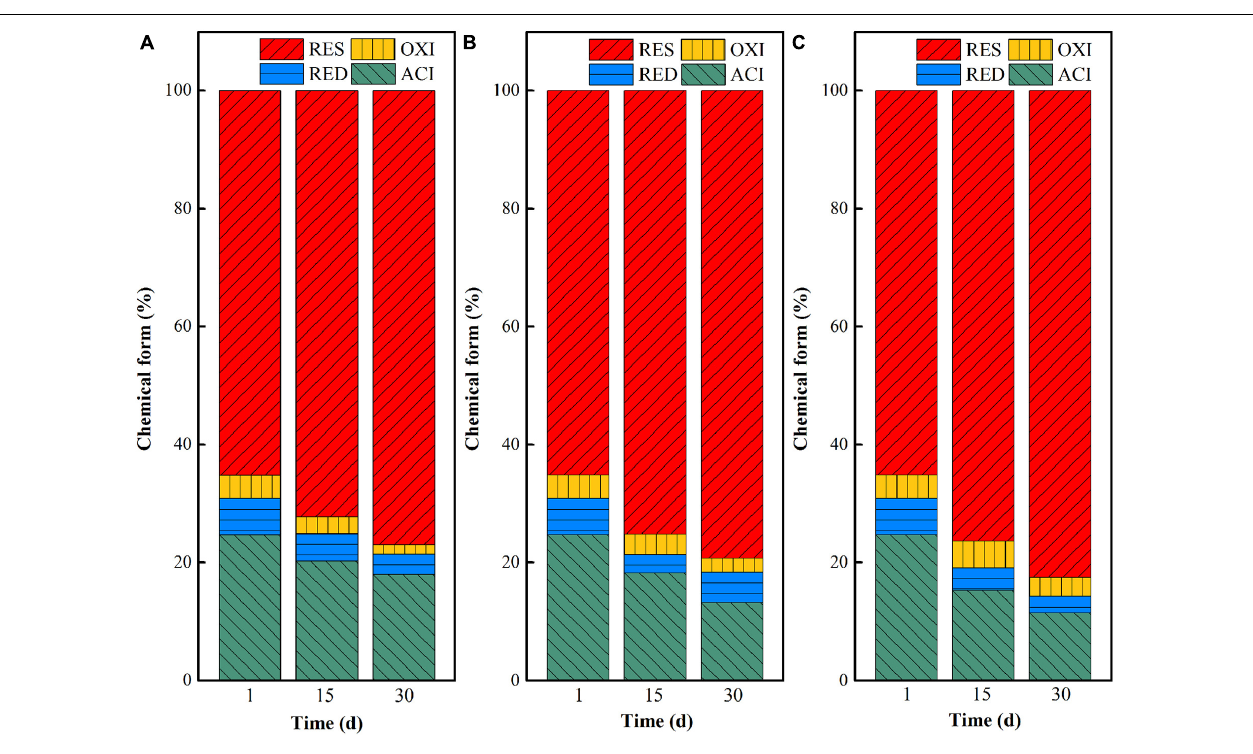
However, ACE and Chao 1 of the three reaction systems all reached their peak values on day 30; that is, the microbial richness reached its maximum. This indicated that exogenous